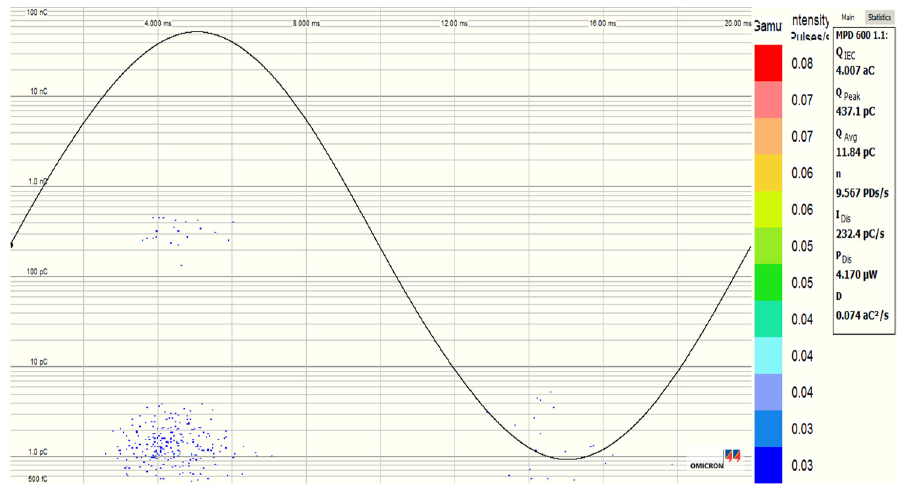
Figure 21. PD pattern of synthetic ester-based NF with Fe 3 O 4 (20 nm, 0.4 g/L) at 13 kV (RMS) voltage level.